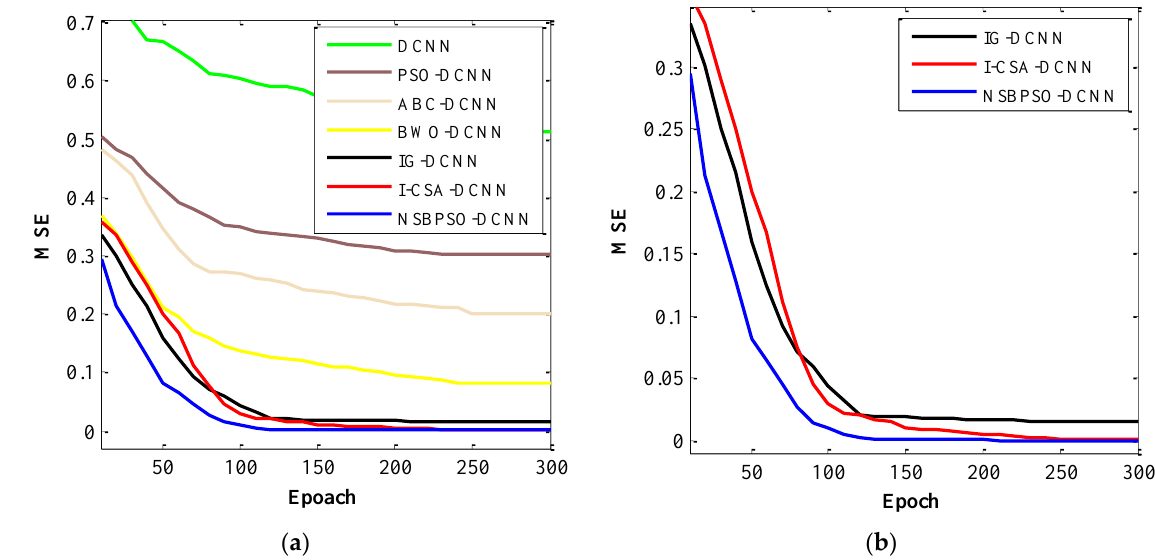
Figure 12. The convergence curve of the architectures: ( a ) All architecture; and ( b ) NSBPSO-DCNN, I-CSA-DCNN, IG-DCNN. Table 6. The results of architectures in the nonparametric statistical test (Wilcoxon